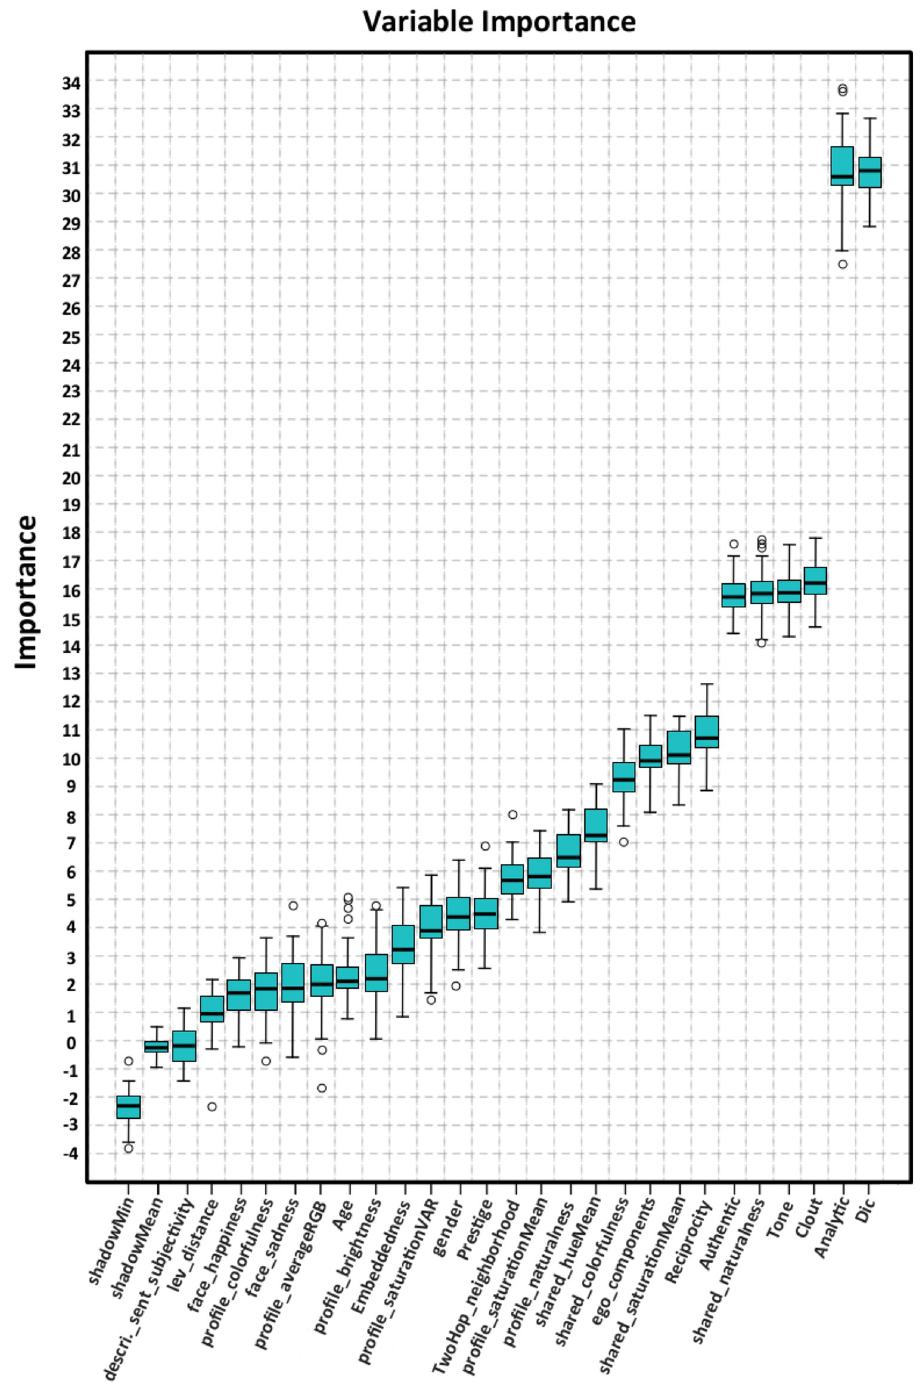
Fig 5. Ranking features obtained from different modalities with an ensemble algorithm.